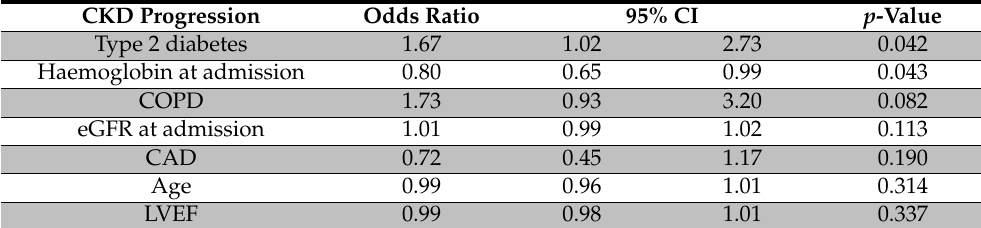
Table 4. Multivariable logistic regression analysis for CKD